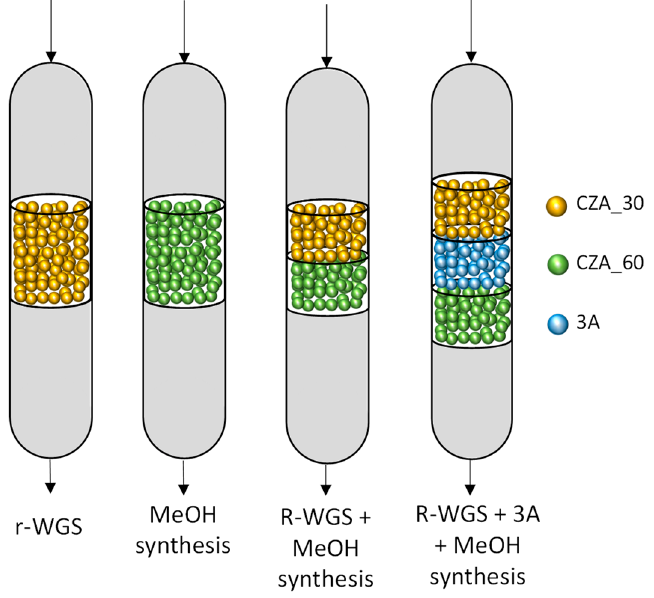
Figure 9. Studied configurations of the catalytic bed.